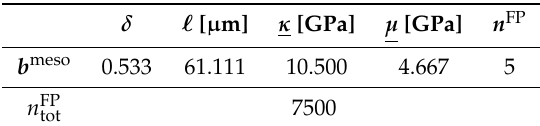
Table 8. Fixed-point iterative algorithm: identified optimal value b meso of hyperparameter b = ( δ , (cid:96) , κ , µ ) for the mesoscopic domain of observation Ω meso